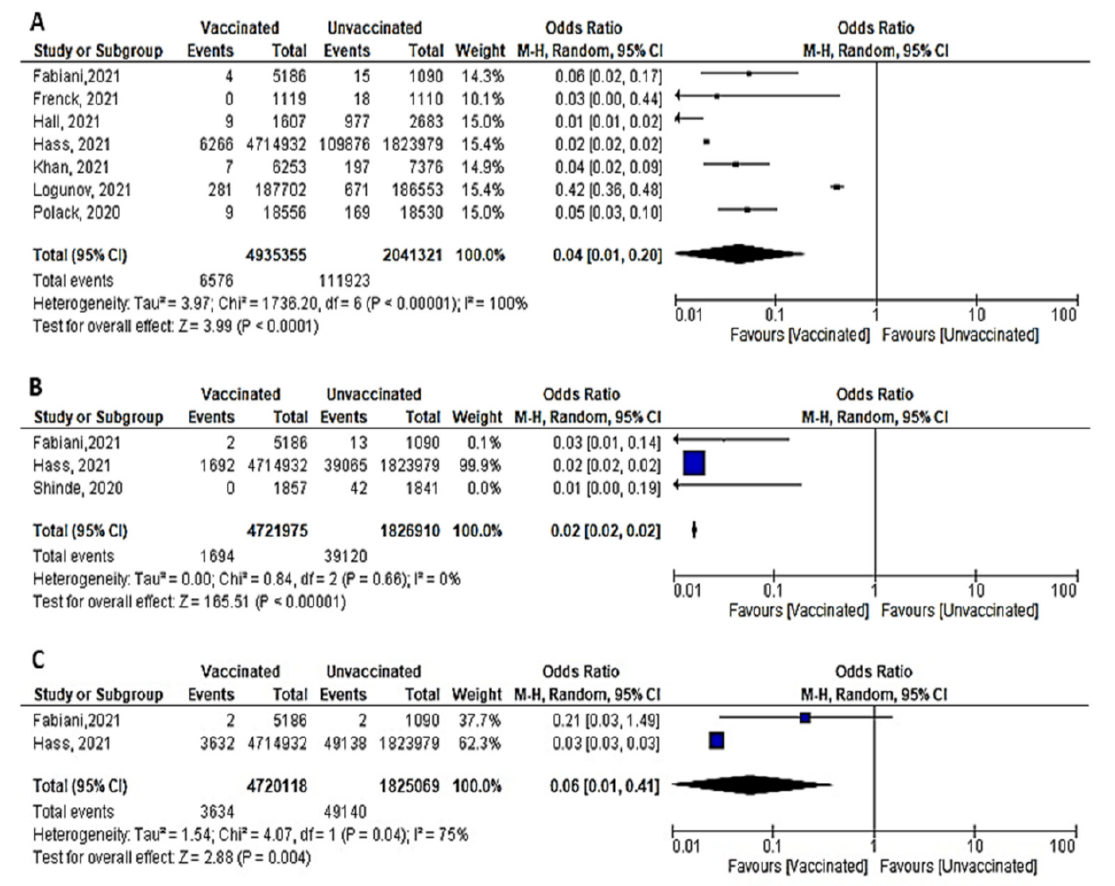
Figure 11. ( A ) Incidence of SARS-CoV-2 infection either symptomatic or asymptomatic after 7 days of 2nd dose of vaccination. ( B ) Incidence of symptomatic SARS-CoV-2 after 7 days of 2nd dose of vaccination. ( C ) Incidence of asymptomatic SARS-CoV-2 after 7 days of 2nd dose of